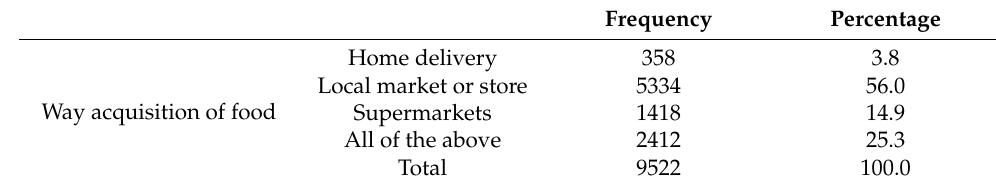
Table 2. Acquisition of food during mandatory confinement because of the COVID-19 pandemic.